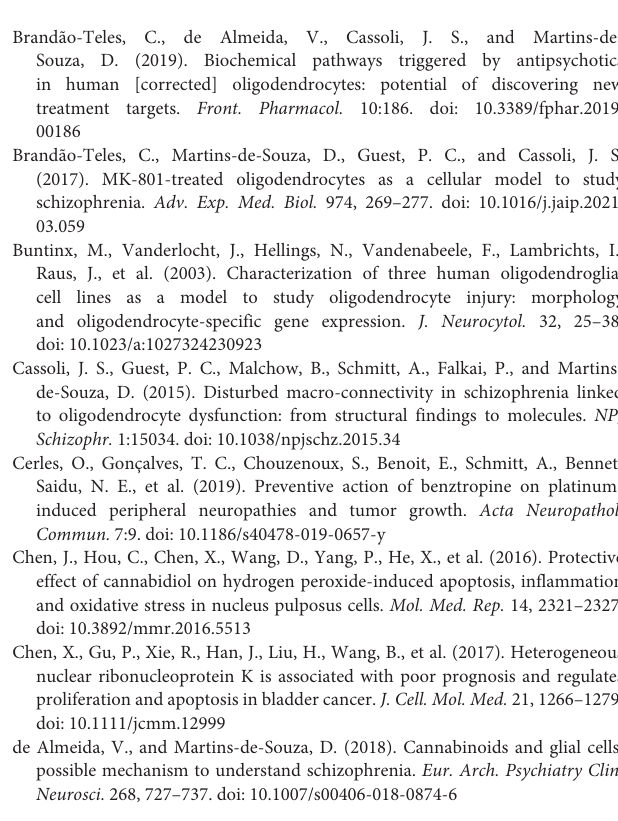
SUPPLEMENTARY FIGURE 1 | A MTT assay was used to measure the percentage of live MO3.13 cells after 48 h and 8 h in growth medium (DMEM), Vehicle (for cuprizone: DMSO, 0.3%; haloperidol and cannabidiol: DMSO, 0.3%; clozapine: DMSO, 0.4%; benztropine: water), and increasing concentrations of cuprizone for 48 h (A) , haloperidol (B) , clozapine (C) , cannabidiol (D) , or benztropine (E) for 8 h ( ∗ P ≤ 0.05; ∗∗∗ P < 0.001; ∗∗∗∗ P < 0.0001; n = 6 wells/condition). SUPPLEMENTARY FIGURE 2 | Bar graph of enriched biochemical pathways in MO3.13 cells treated with cuprizone 10 µ M, 48 h (A) , haloperidol (B) , clozapine (C) , cannabidiol (D) , and benztropine (E) , colored by p -value, created in Metascape. Colored lines represent p -values, which range between 10 − 20 and 10 − 2 . SUPPLEMENTARY FIGURE 3 | Network of pathways affected by cannabidiol, benztropine, clozapine, and haloperidol co-treatments, according to proteomic analysis, showing the percentage of visible genes of a term or pathway and the hub genes that enriched KEGG pathways. The gene ontology interaction network was obtained by functional enrichment analysis using the ClueGO plug-in in Cytoscape. All terms were selected by significance ( p < 0.05) following a Benjamini-Hochberg correction. SUPPLEMENTARY TABLE 1 | Proteins differentially regulated by treatments. SUPPLEMENTARY TABLE 2 | Pathways associated with proteome changes induced by